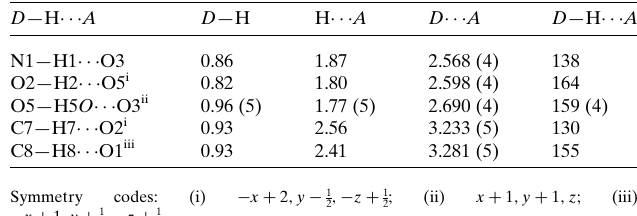
Table 1 Hydrogen-bond geometry (A˚ , (cid:3) ).